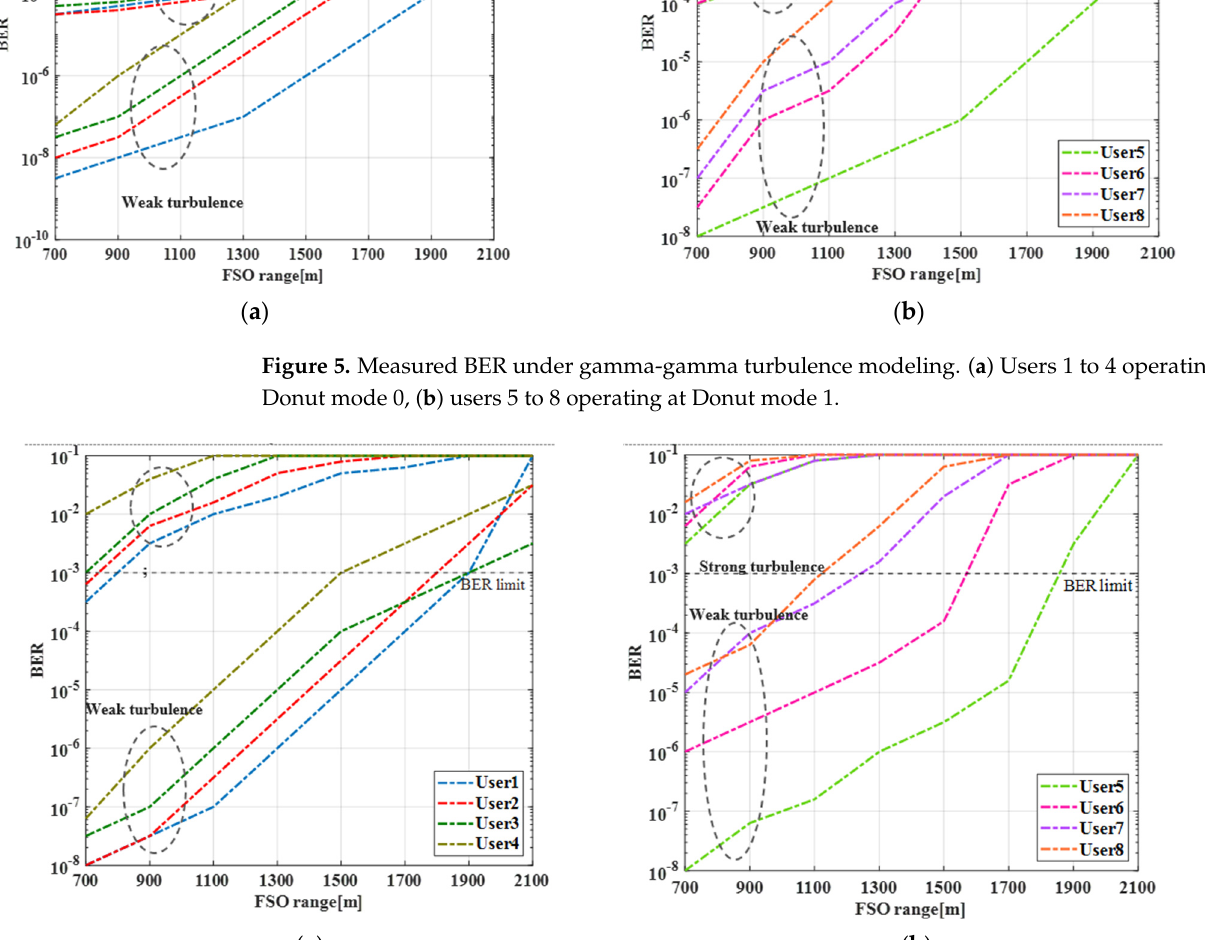
Figure 6. Measured BER under log-normal turbulence modeling. ( a ) Users 1 to 4 operating at Donut mode 0, ( b ) users 5 to 8 operating at Donut mode 1.